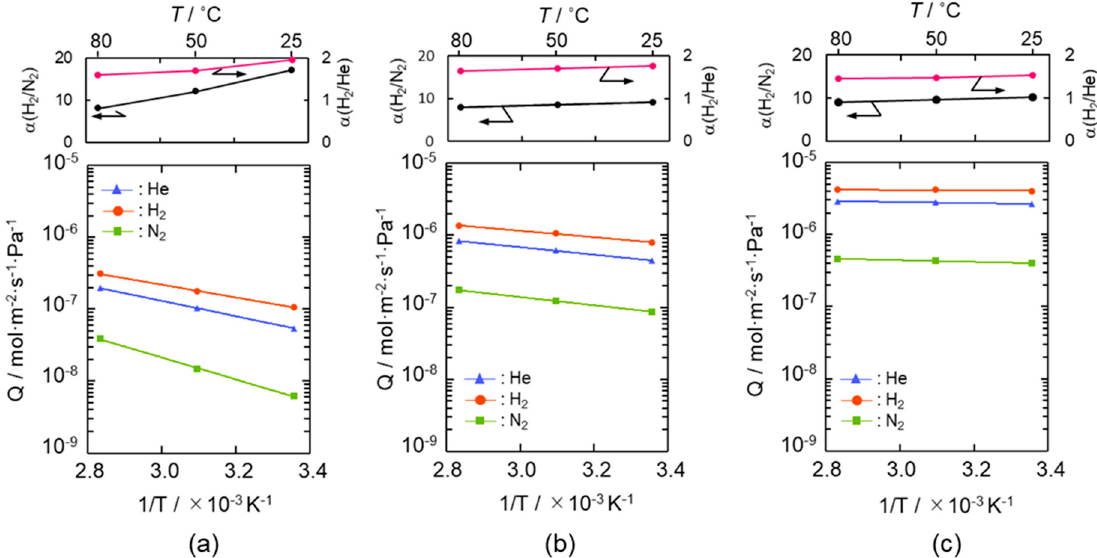
Figure 4. Gas permeation behaviors under dry condition of the supported mesoporous γ -Al 2 O 3 membrane after modification with AHPCS and subsequent heat treatment under flowing Ar at ( a ) 300 °C, ( b ) 400 °C and ( c ) 500 °C.